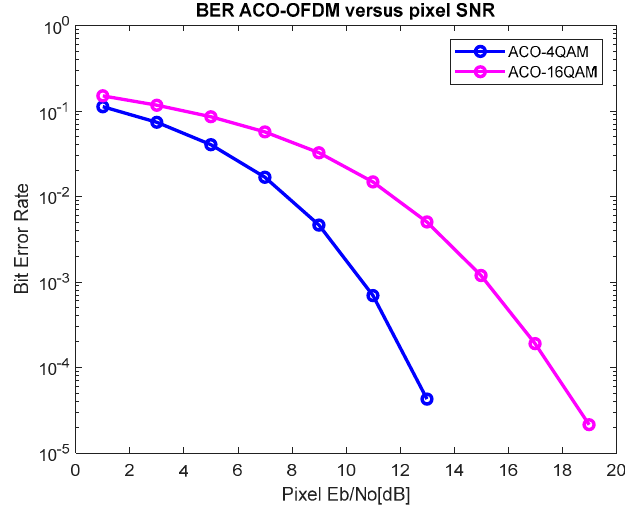
Figure 6. Simulation of BER ACO-OFDM versus pixel SNR.